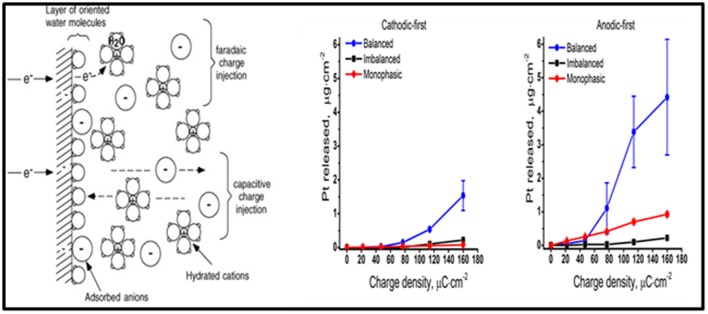
The electrode-electrolyte interface. A schematic representation of the electrode-electrolyte interface [from (Merrill et al., 2005 with permission) far left]. The concentration of Pt measured at different charge densities for cathodic-first (middle) and anodic-first (far right) stimulation waveforms (Kumsa et al., 2016 with permission).